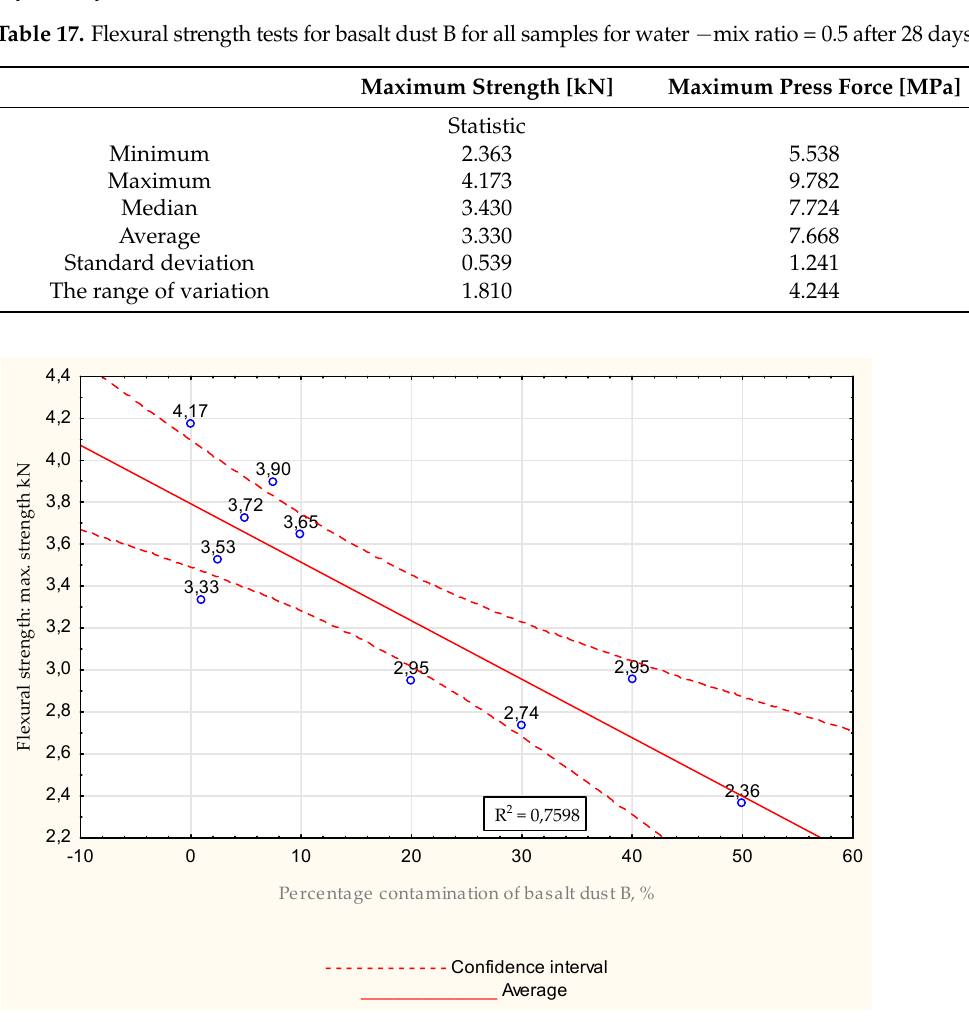
Figure 27. Average values obtained during flexural strength tests after 28 days for water − mix ratio = 0.5, maximal strength.